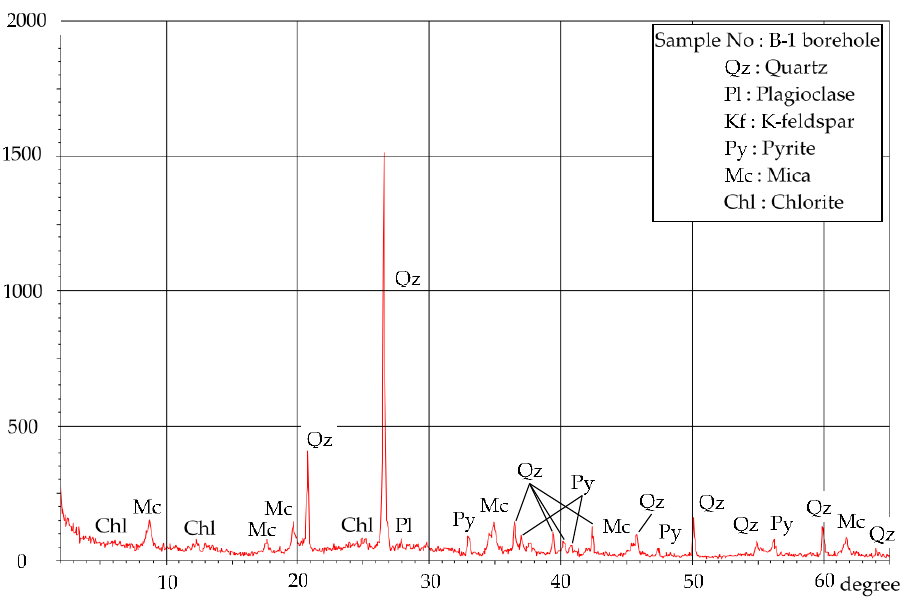
Figure 5. X-ray diffraction spectrum of the B-1